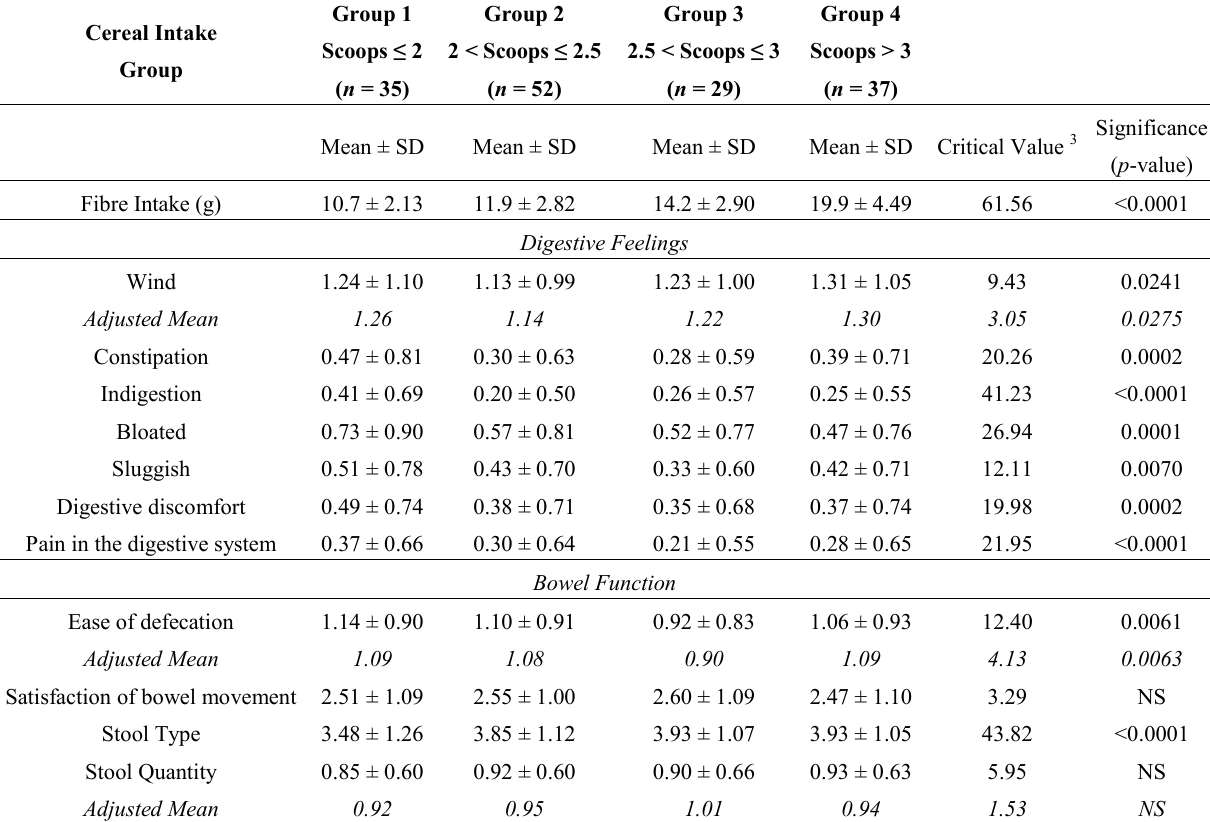
Table 4. Fibre intake, Digestive feelings 1 , Bowel function 2 and General wellbeing 1 according to Cereal Intake Group (153 participants) during the 14 day fibre intervention period. All mean values are unadjusted except where